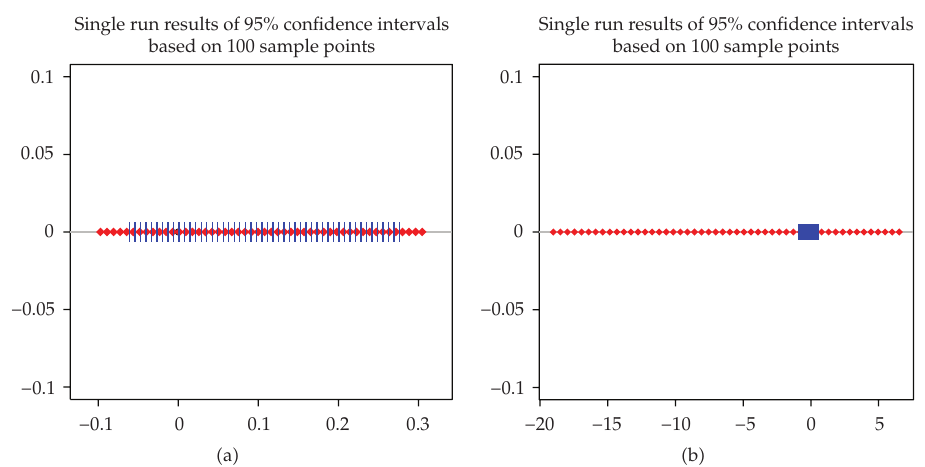
Figure 2: 95% CIs by t (cid:2) red one (cid:3) and new procedures (cid:2) blue one (cid:3) for the mean of F based on 100 sample points from F : (cid:2) a (cid:3) F (cid:4) 0 . 95 N (cid:2) 0 , 1 (cid:3) (cid:7) 0 . 5 N (cid:2) 1 . 5 , 0 . 1 2 (cid:3) and (cid:2) b (cid:3) F (cid:4) t (cid:2) 1 (cid:3) .